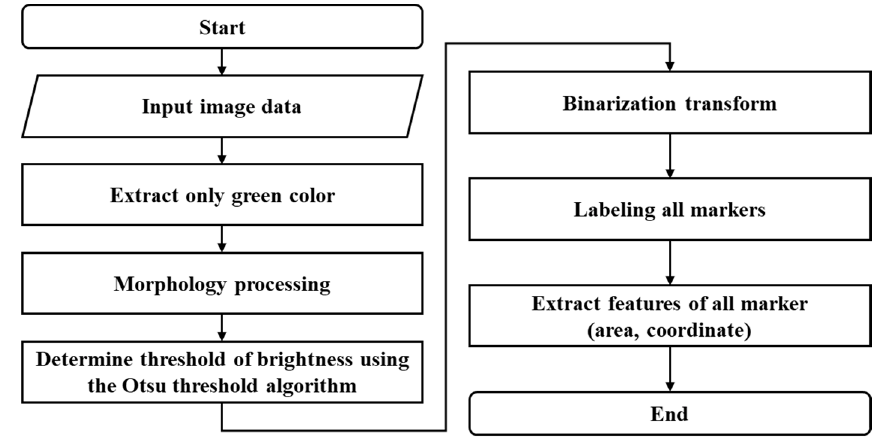
Figure 3. Input image processing diagram.